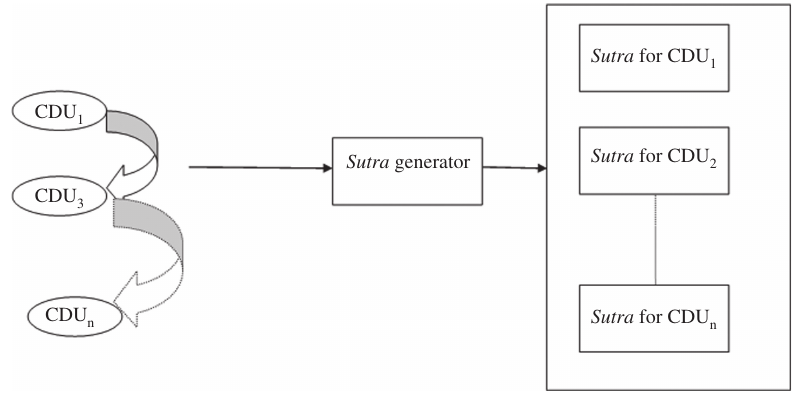
Figure 8. Formation of Sutra for a Single Text Document.